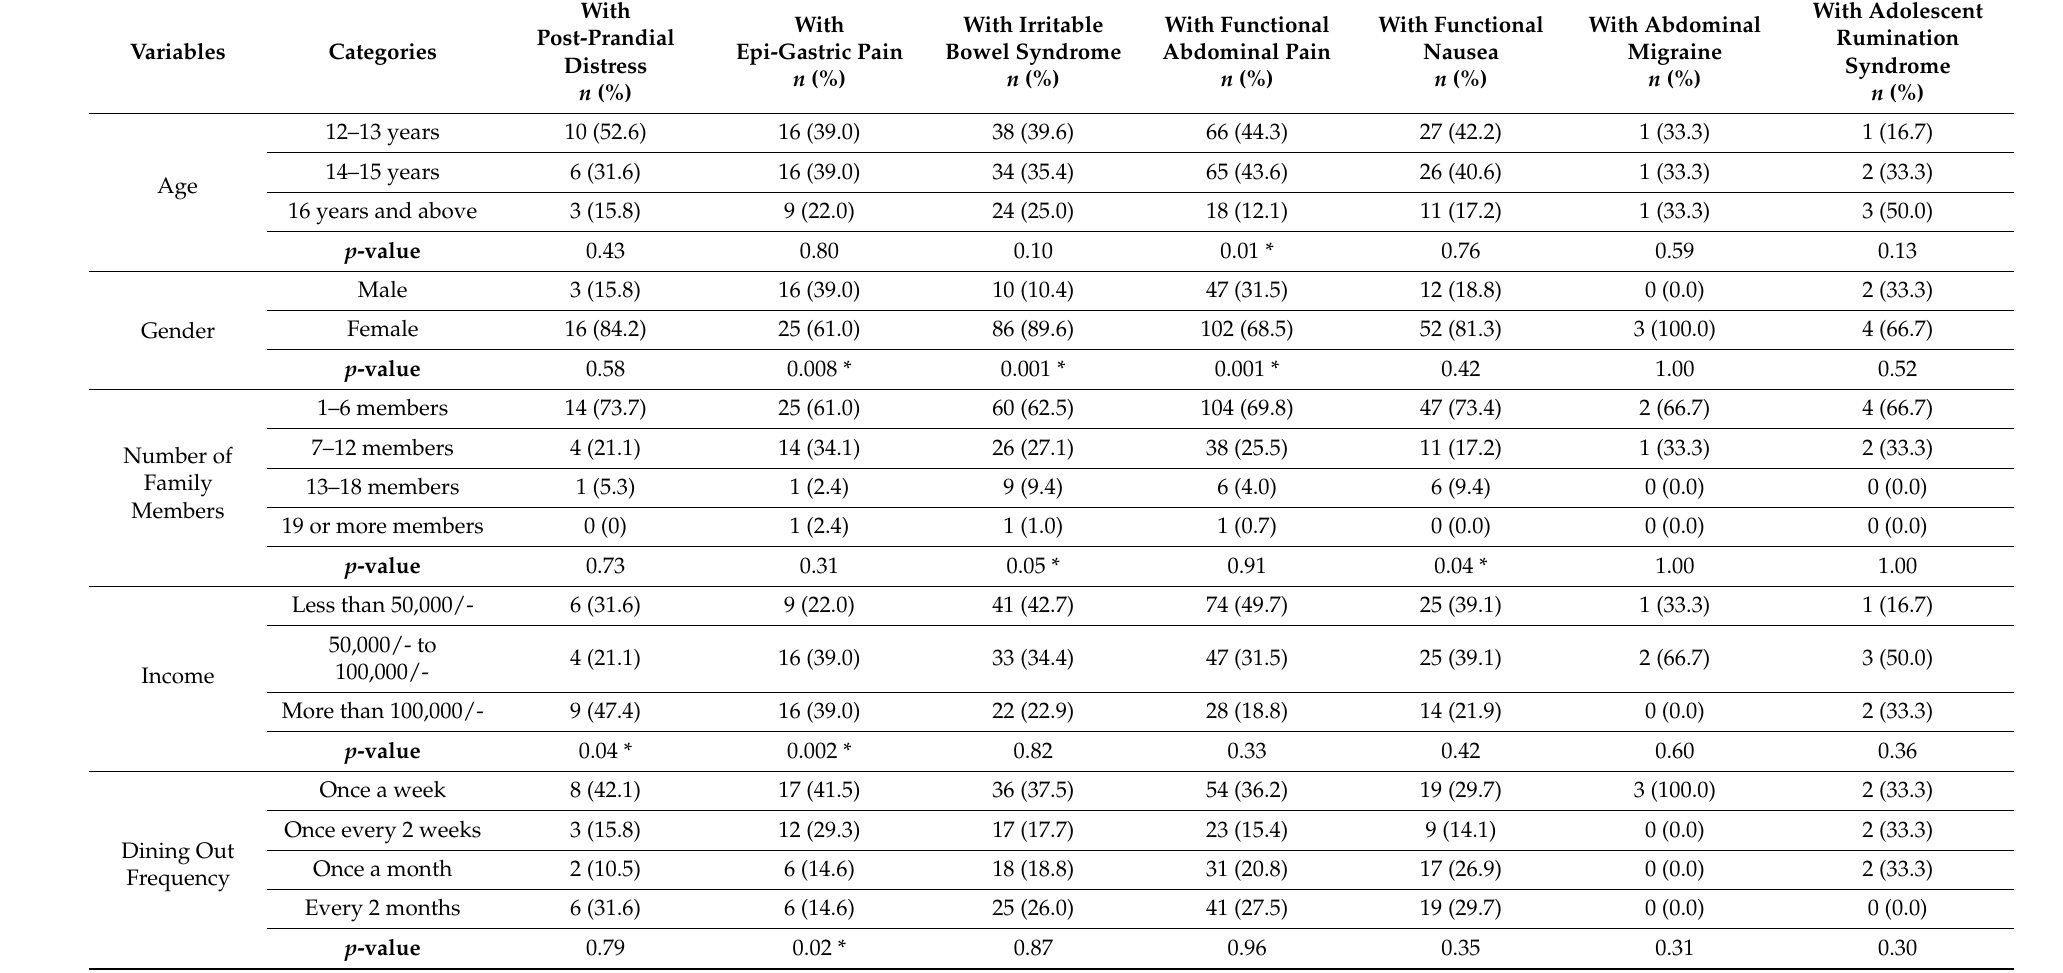
Table 4. Association of Functional Gastrointestinal Diseases with Socio-Demographic and Dietary